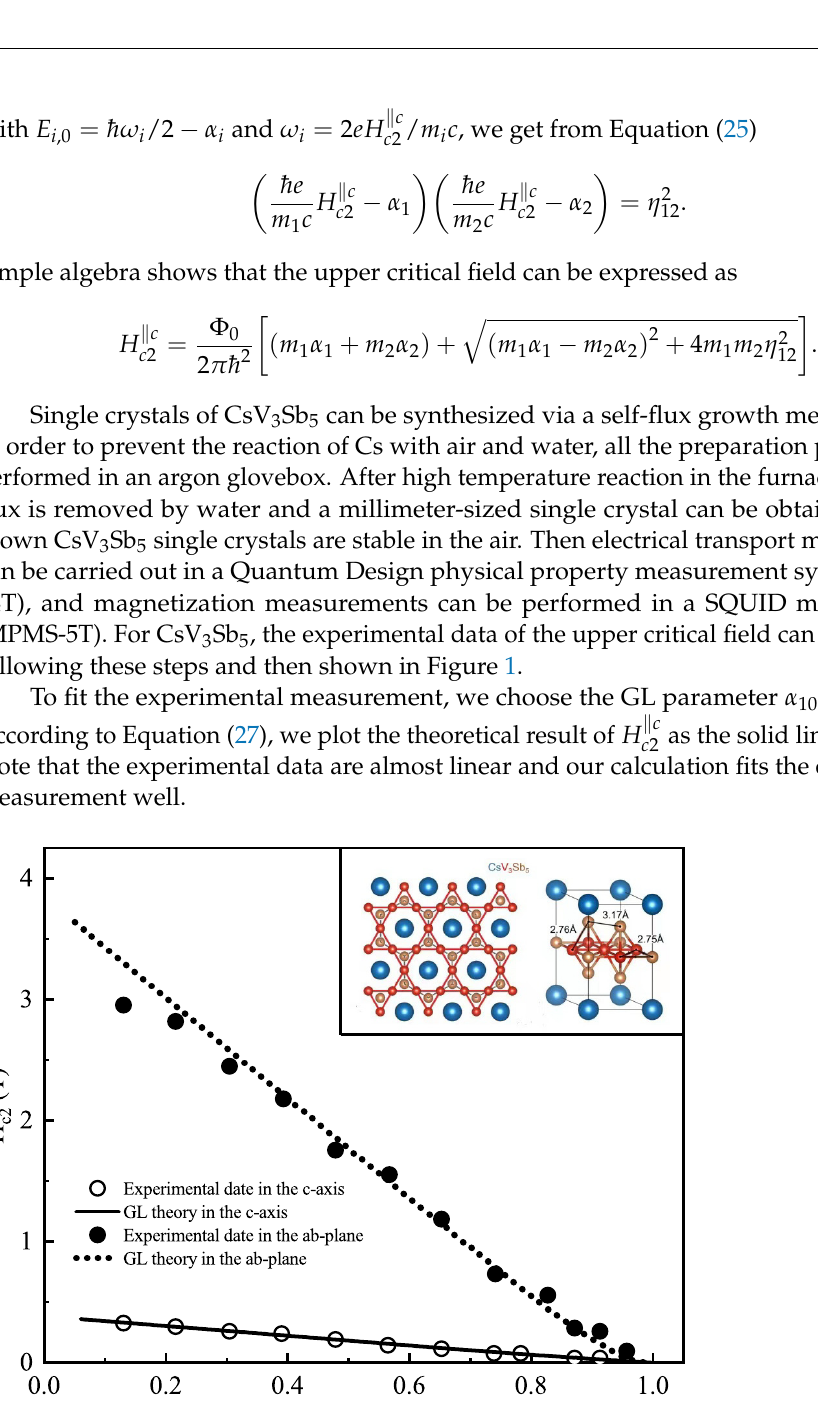
Figure 1. Upper critical field H experimental data are from Ref. [43]. The inset shows the schematic crystal structure of CsV 3 Sb 5